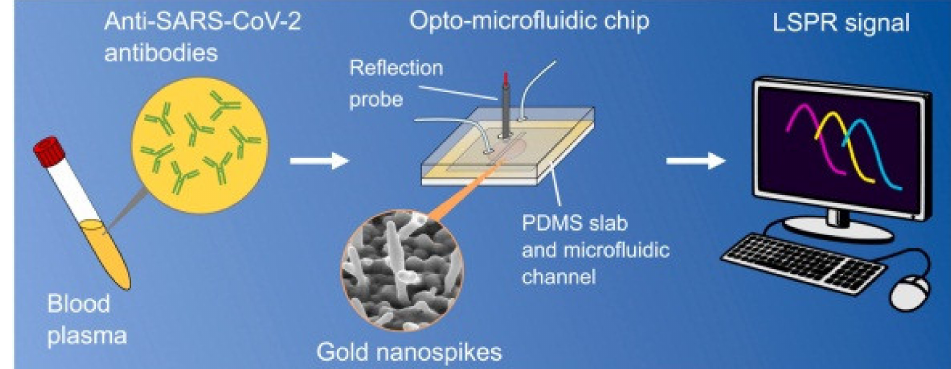
Figure 15. The opto-microfluidic chip with gold nanospikes (reprinted with permission from Ref. no. [156], copyright 2020,